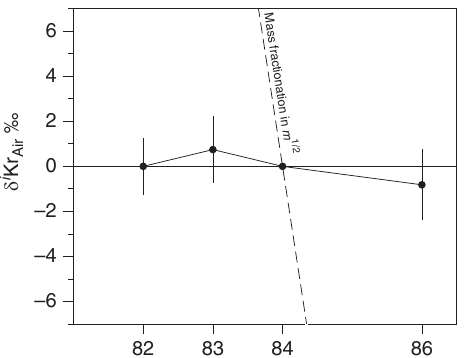
Figure 5 | Isotopic ratios of krypton in fluid inclusions of Barberton quartz crystals. Isotopic ratios are expressed with the delta notation relative to 84 Kr and to the isotopic composition of the modern atmosphere. The dashed line represents the isotopic fractionation measured for Xe (13 % u (cid:2) 1 ) propagated towards Kr following a mass fractionation law proportional to m 1/2 . Errors at 2 s .